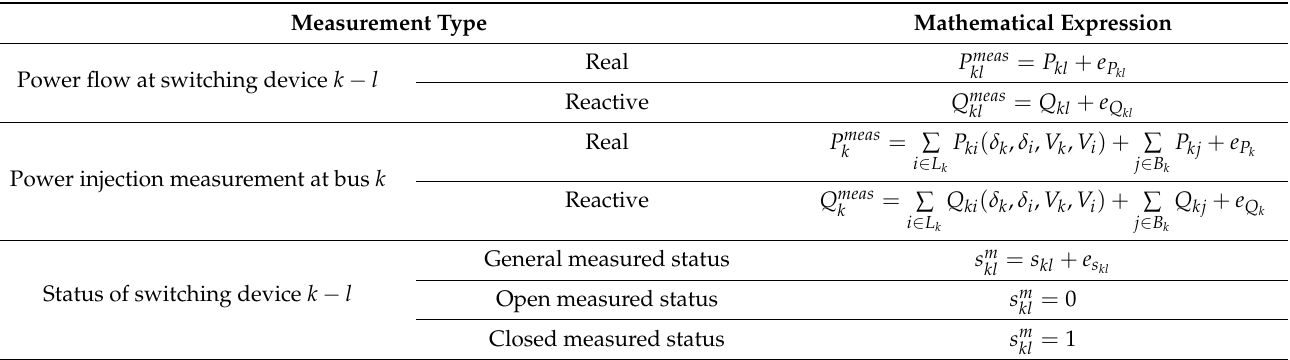
Table 1. Real-time measurements [54].